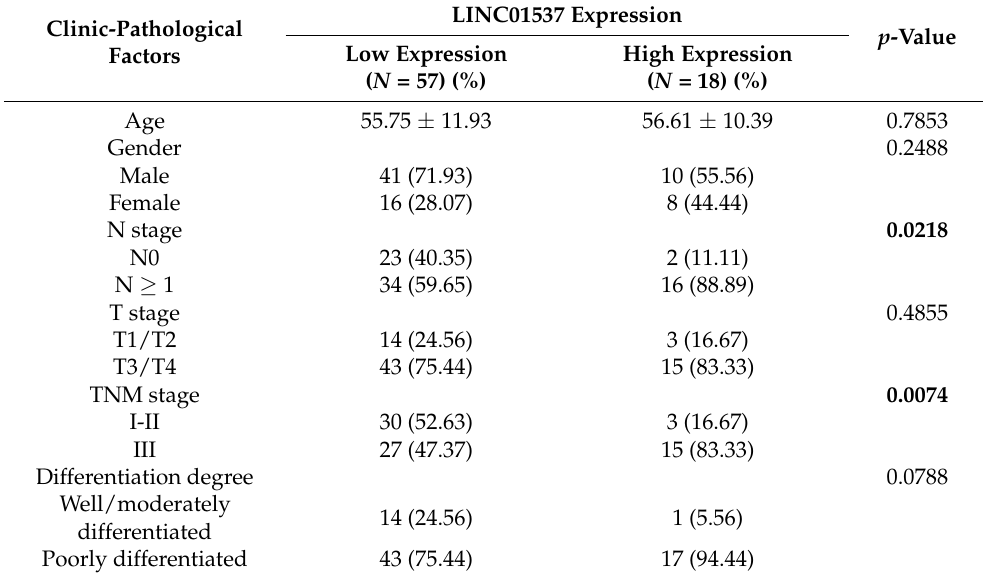
Table 1. The clinic-pathological factors of GC